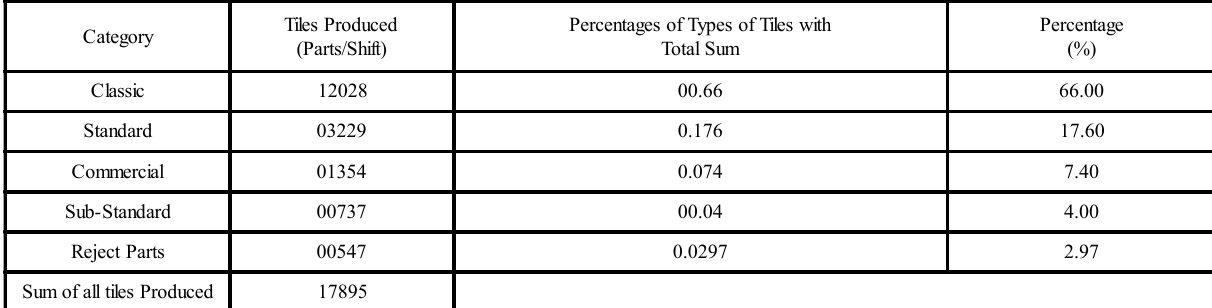
TABLE 7. AMOUNT OF PRODUCTION OF DIFFERENT CATEGORY TILES